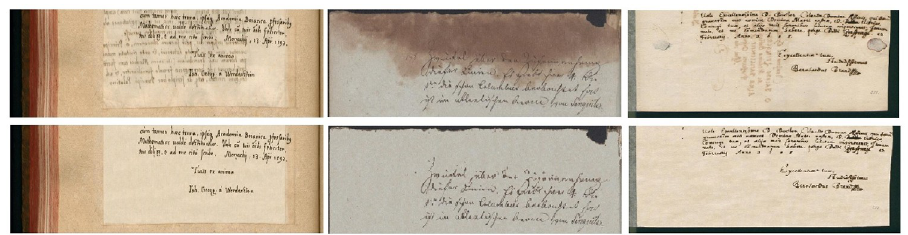
Fig 4. Example of images from DIBCO-2019 [37]: Input degraded image (top row), restored image using the proposed method (bottom row).